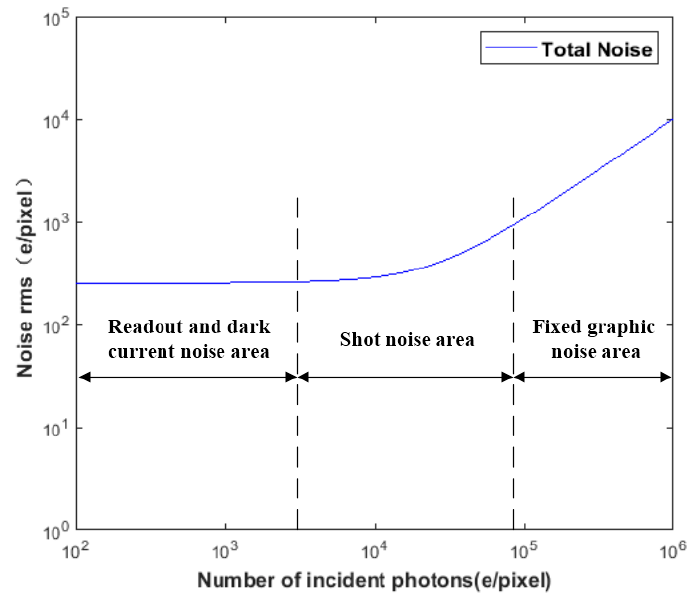
Figure 8. The total noise electrons in the system.